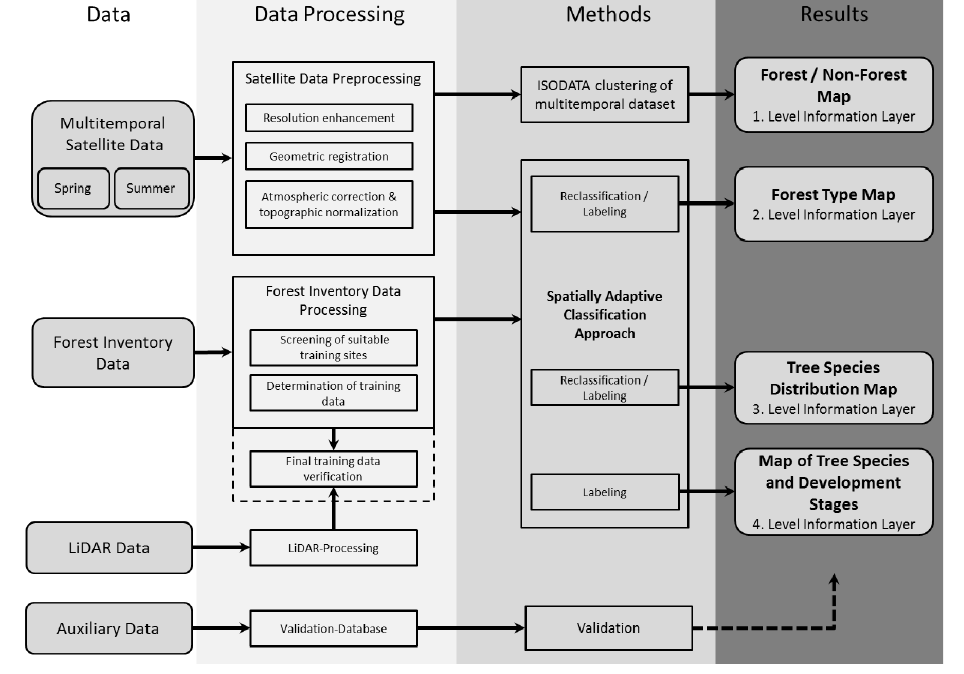
Figure 3. Schematic of the spatially adaptive classification approach to deriving high-resolution forest information